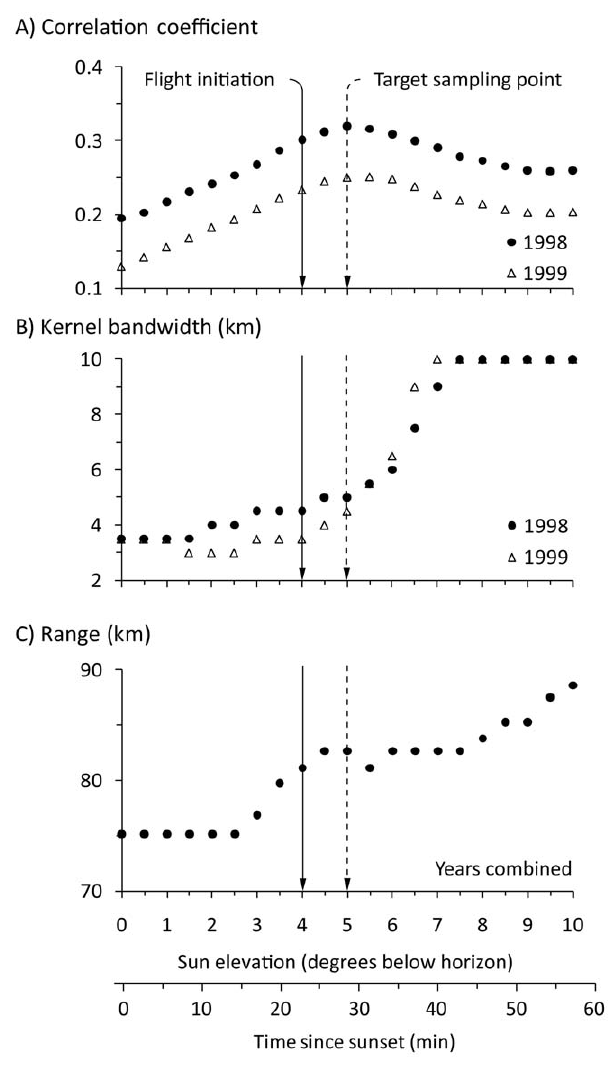
Figure 3. Accuracy, precision, and detection range of radar observations of birds during evening flight. Time series depicting the change in radar data accuracy, precision, and detection range as measured, respectively, by A) the mean correlation between mean radar reflectivity (i.e., index of bird density) and the mean kernel density of radio-marked waterfowl locations within a 0.5 km bandwidth, B) the kernel density bandwidth size of the maximum mean correlation coefficient between mean radar reflectivity and mean kernel density of radio-marked waterfowl locations, and C) the mean maximum range that the radar detected birds in the air around the KDAX radar among 2 000 bootstrapped samples of 30 individual sample volumes during the winters of 1998–1999 ( n =18 days) and 1999–2000 ( n =26 days). Standard errors for plots A and C were too small for display.